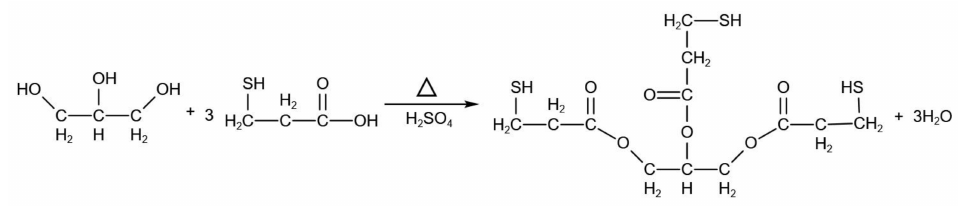
Figure 1. Synthesis reaction formula of polythiol curing agent.